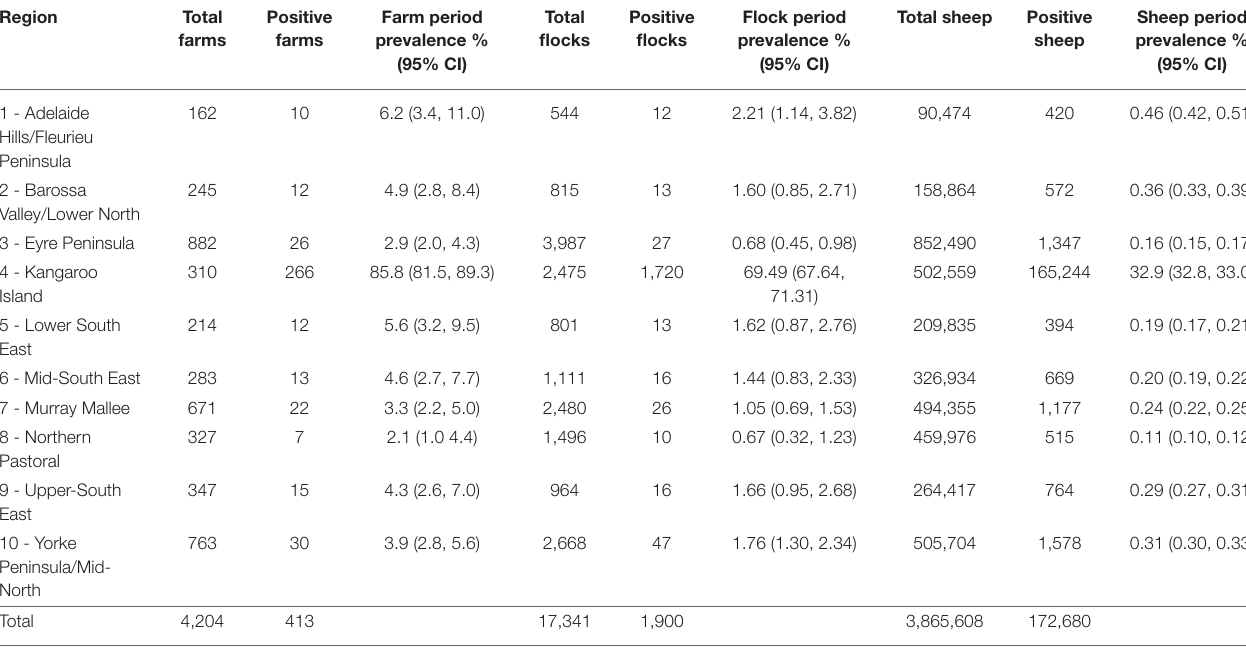
TABLE 2 | Regional summary statistics at farm-, flock-, and animal-level, showing number sampled, number positive to sarcocystosis and period prevalence over 2007–2017 period.